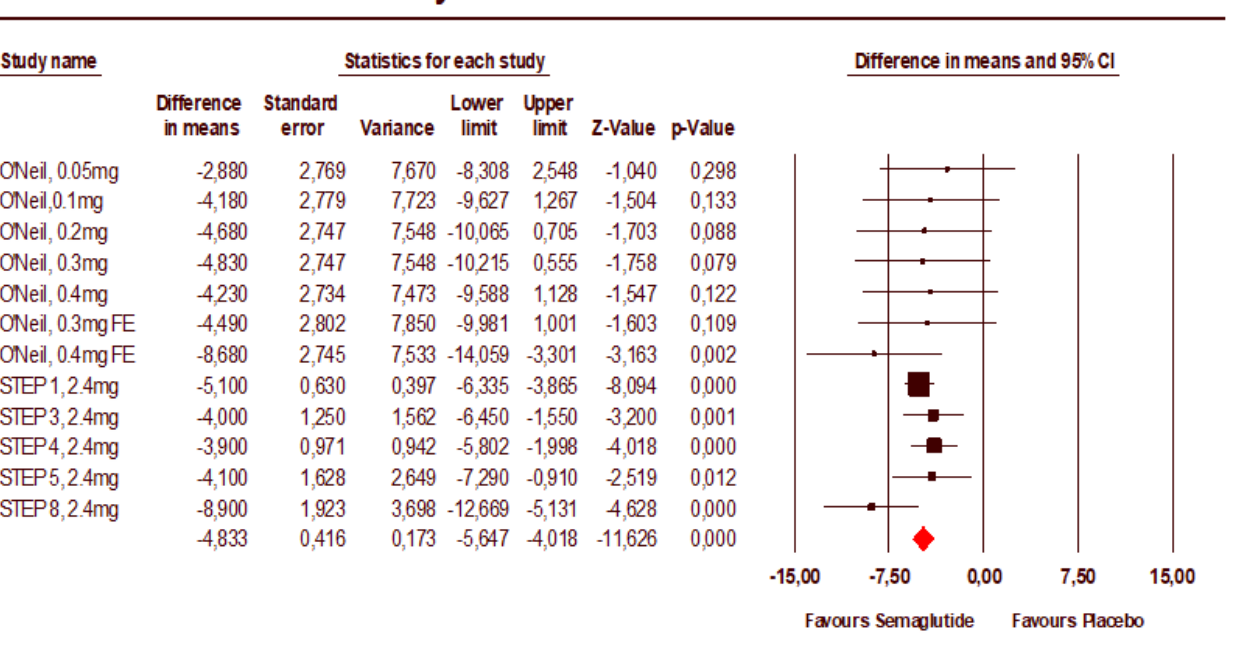
Figure 2. Forest plot of semaglutide vs. placebo showing the pooled weighted mean difference for SBP (random effects model).